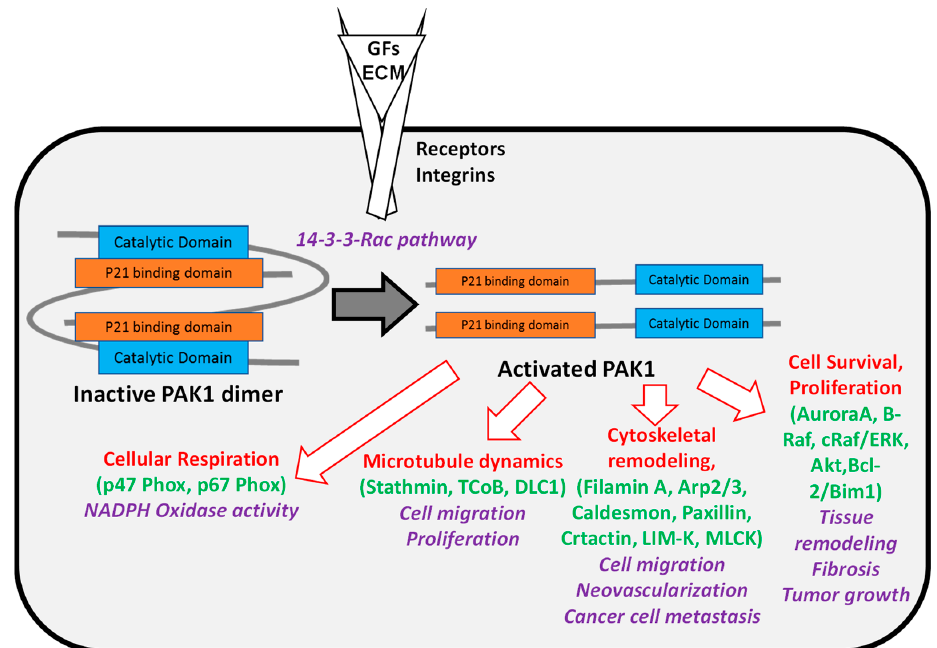
Figure 2. Activation of PAK1 by growth factors (GFs) and extracellular matrix (ECM) and the effect of PAK1 activation on PCa cellular function. Interaction of GTP-bound Rac/cdc42 releases PAK1 from auto-inhibition and promotes cytoskeletal dynamics, motility, invasion, proliferation, and survival in cancer cells and other cell types by phosphorylating a plethora of substrates.